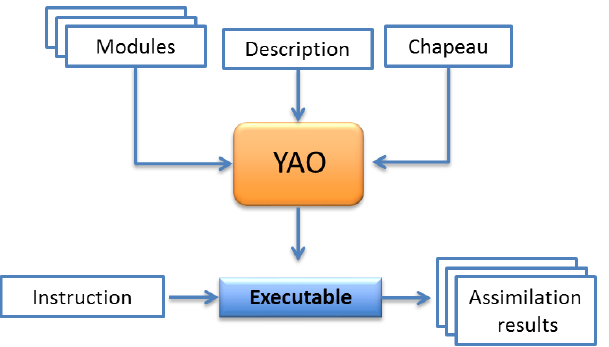
Figure 3. Structure of a project in YAO. The software generates an executable program from input modules, hat and description files. The generated program reads an instruction file to perform assimi- lation